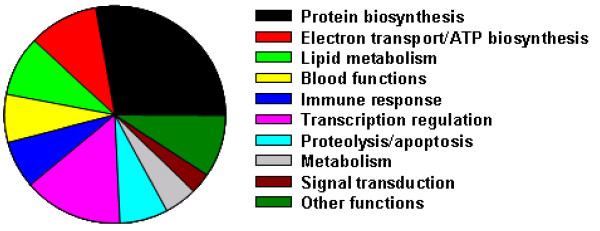
Summary of differentially expressed genes that have significant tBLASTX identity with genes assigned to GO biological function categories.